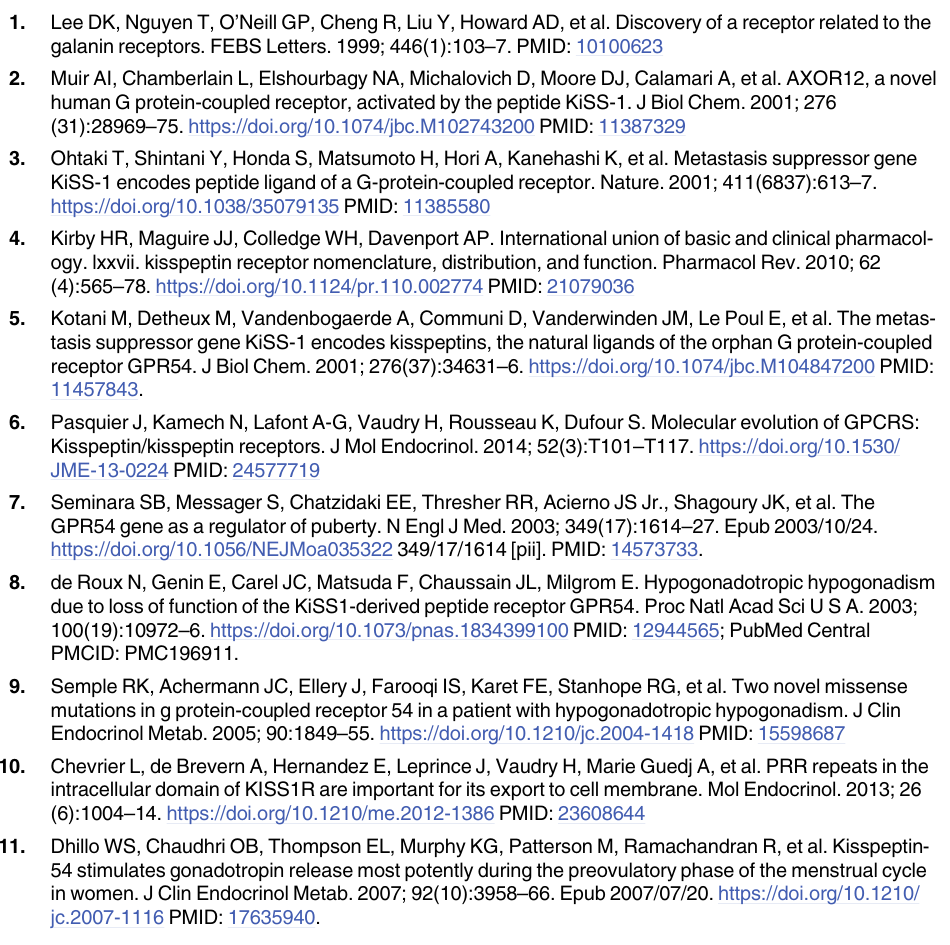
S4 Fig. Entire blots of the representative western blots plotted in S1 Fig. Phosphorylation of ERK1/2 stimulated by KP-10 in HEK293 (A) and MCF-7 (B) cells.